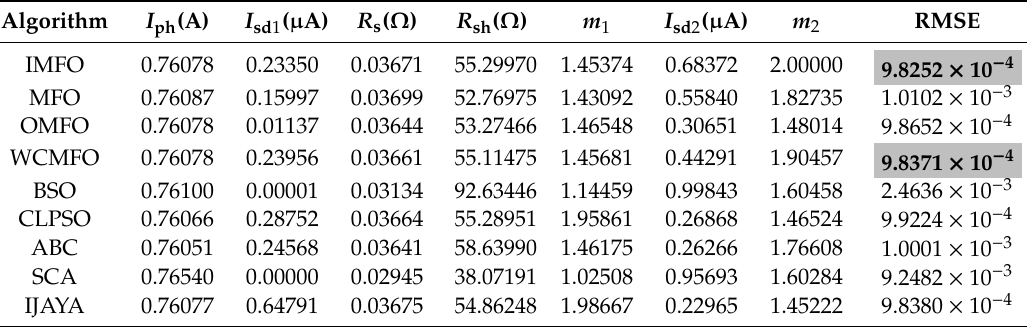
Table 3. Comparison among di ff erent algorithms on the double diode